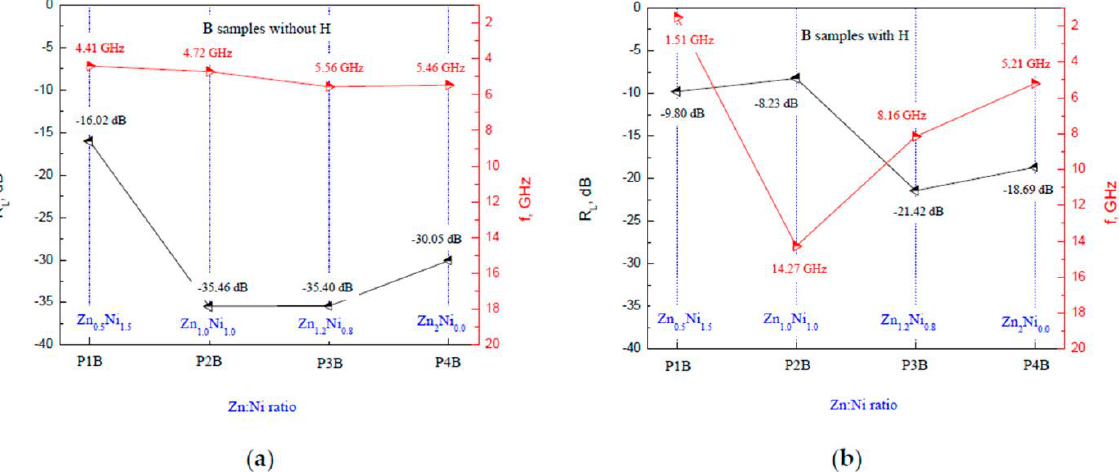
For the B series of samples, shown in Figure 8, two main peaks were observed with